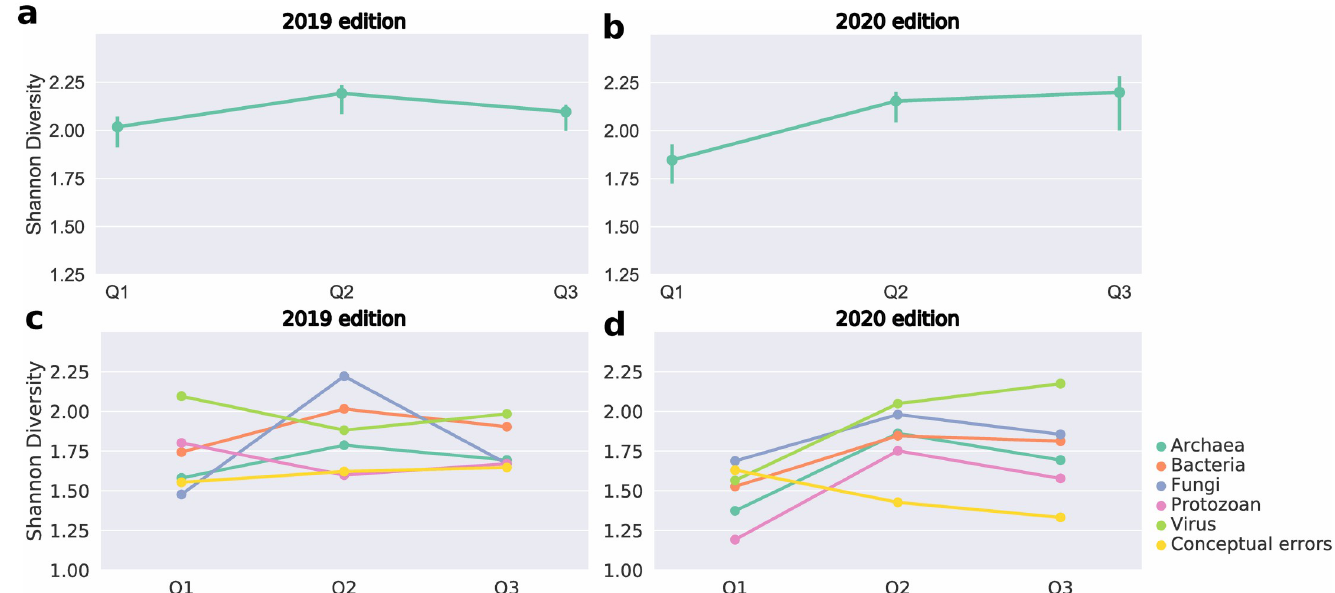
Fig 2. Word richness in the questionnaires. Graphs showing the variation in the student’s response richness (calculated by the Shannon index) over the three surveys: Q1, applied before the beginning of “Adopt a Microorganism”; Q2, applied after the hands-on practical activities in 2019 and immediately after the end of the Facebook 1 discussions in 2020; Q3, applied five months after the end of the project. [a] variation in the Shannon index for all surveys analyzed in 2019; [b] variation in the Shannon index for all surveys analyzed in 2020; [c] variation in the Shannon index of the surveys answered by each group (Archaea, Bacteria, Fungi, Virus and Protozoan) in 2019; [d] variation in the Shannon index of the surveys answered by each group (Archaea, Bacteria, Fungi, Virus and Protozoan) in 2020.